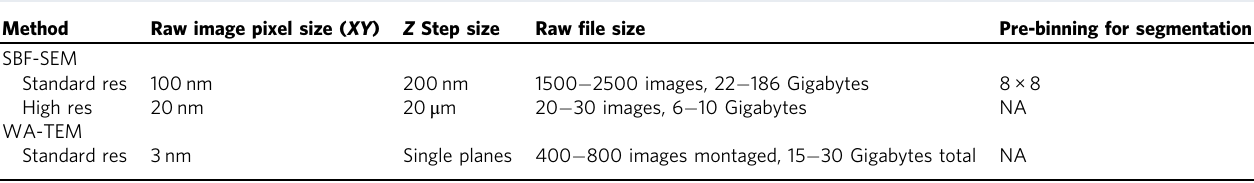
Table 2 Electron microscopy (EM) parameters for image capture and